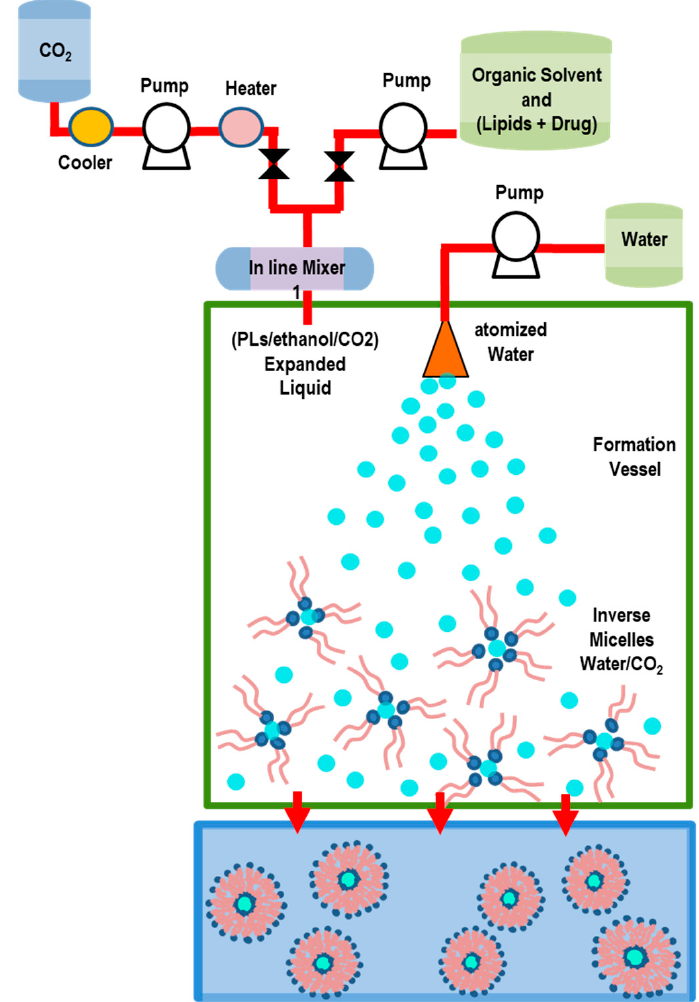
Figure 12. SuperLip method and mechanism of liposome formation. A high-pressure vessel is filled with an expanded liquid mixture (formed by PLs/ethanol/CO 2 containing drugs). Water droplets are produced by atomization inside a high-pressure vessel. These droplets are rapidly surrounded by a lipid layer, forming a w/CO 2 emulsion (inverted micelle). Finally, liposomes ( w / w emulsion) are formed when they fall in the water pool located at the bottom of the vessel.